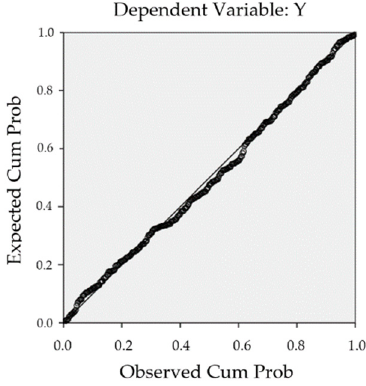
Figure 9. Standard residuals.